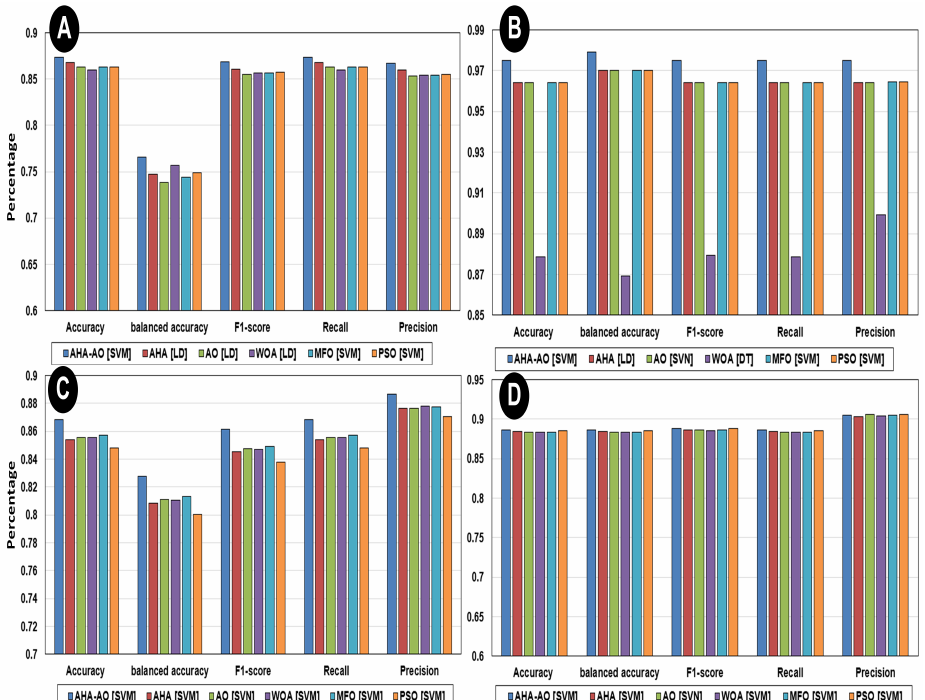
Figure 7. Comparison among the best classifiers with every optimizer and the four datasets: ( A ) for the ISIC-2016 dataset, ( B ) for the PH2 dataset, ( C) for the Chest dataset, and ( D ) for the Blood